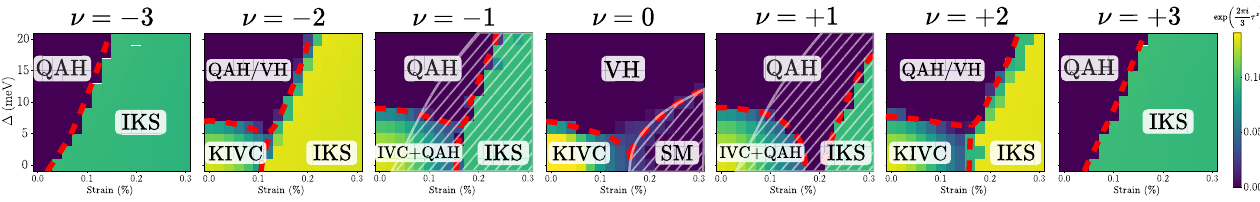
FIG. 2. Summary of phases found in self-consistent Hartree-Fock at all integer fillings ν for different heterostrains and substrate potentials Δ , with nonlocal tunneling included. Color plot diagnoses IVC order [dark blue indicates unbroken U ð 1 Þ V symmetry]. Dashed red lines indicate approximate phase boundaries, and hatched areas denote absence of a charge gap. Properties of each phase are tabulated in Table I. The phase diagrams here are presented in greater detail in Figs. 3 and 6. (IKS, incommensurate Kekul´e spiral; QAH, quantized anomalous Hall state; KIVC, Kramers intervalley coherent state; VH, valley Hall state; IVC, intervalley coherence; SM,